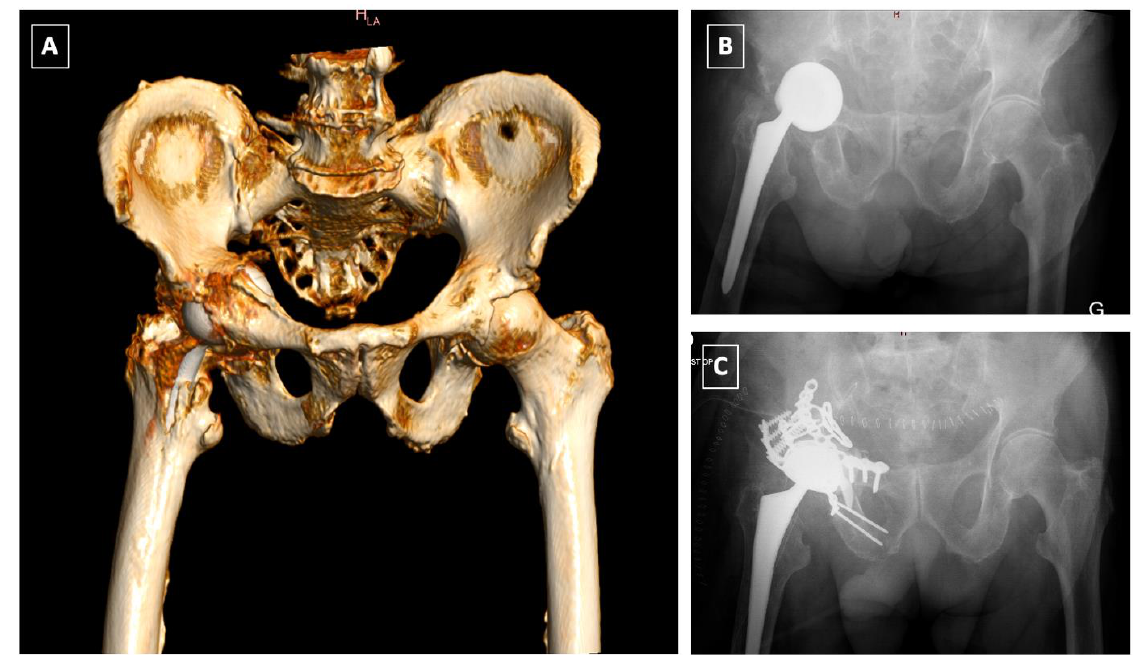
Figure 5. Late postoperative T-type fracture ( A , B ): ORIF of the anterior column using a Stoppa approach followed by ORIF of the posterior column and acetabular reconstruction using a Burch- Schneider Antiprotrusio cage via a Kocher-Langenbeck approach ( C ).